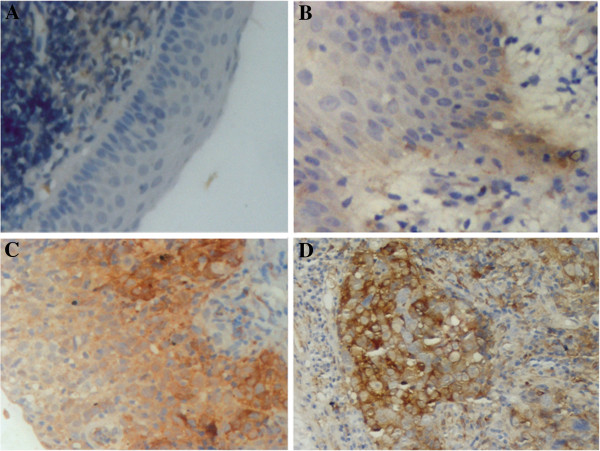
Detection of BCAT1 protein in different pathological stages of NPC. (A) Normal pseudo-stratified ciliated epithelium. (B) Low-to-moderate grade atypical hyperplasia tissue. (C) High-grade atypical hyperplasia tissue. (D) NPC tissue. The results demonstrated that the expression level of BCAT1 protein had increased significantly since early pathological stages of NPC.